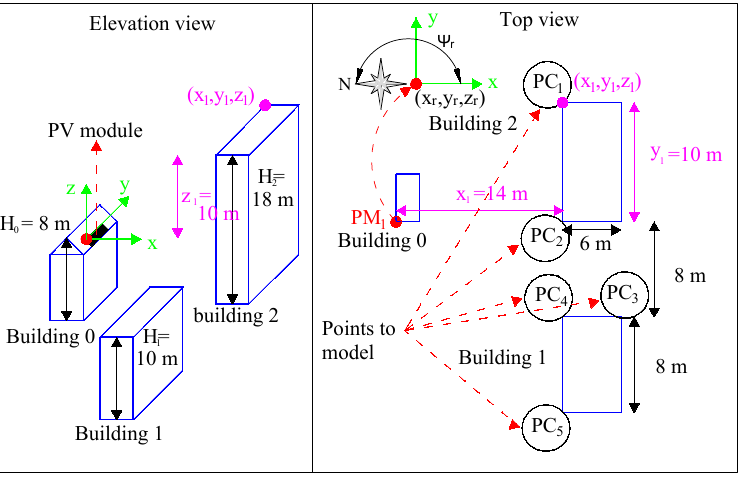
Figure 3. Geometry of the location of the PVM and the objects that can cast shadows. Left: depth view. Right: floor plan. Source: modified from